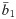
Barcode ensemble of a sample.(A) Schematic representation of the barcode ensemble of a genomic sample. Persistent homology is computed for each genomic interval of a partition of the sequence. Barcodes associated to different genomic intervals capture different recombination events. The union of all barcodes is the barcode ensemble. The total number of intervals in the barcode ensemble is denoted as b¯1. The partition is chosen such that b¯1 is maximized. (B) Comparison between lower bounds b¯1≤R¯min and RMG ≤ Rmin in coalescent simulations. Values of b¯1 and RMG for simulated samples of 40 sequences with 12 segregating sites, sampled from a population under the coalescent model with recombination. 4,000 samples were simulated in total. The colored band represents the interdecile range, whereas the central line represents the mean. The values of b¯1 and RMG are strongly correlated (Pearson’s r = 0.98, p < 10−100). At very high recombination rates, b¯1 tends to be larger than RMG, as cases where R¯min>Rmin occur more frequently.